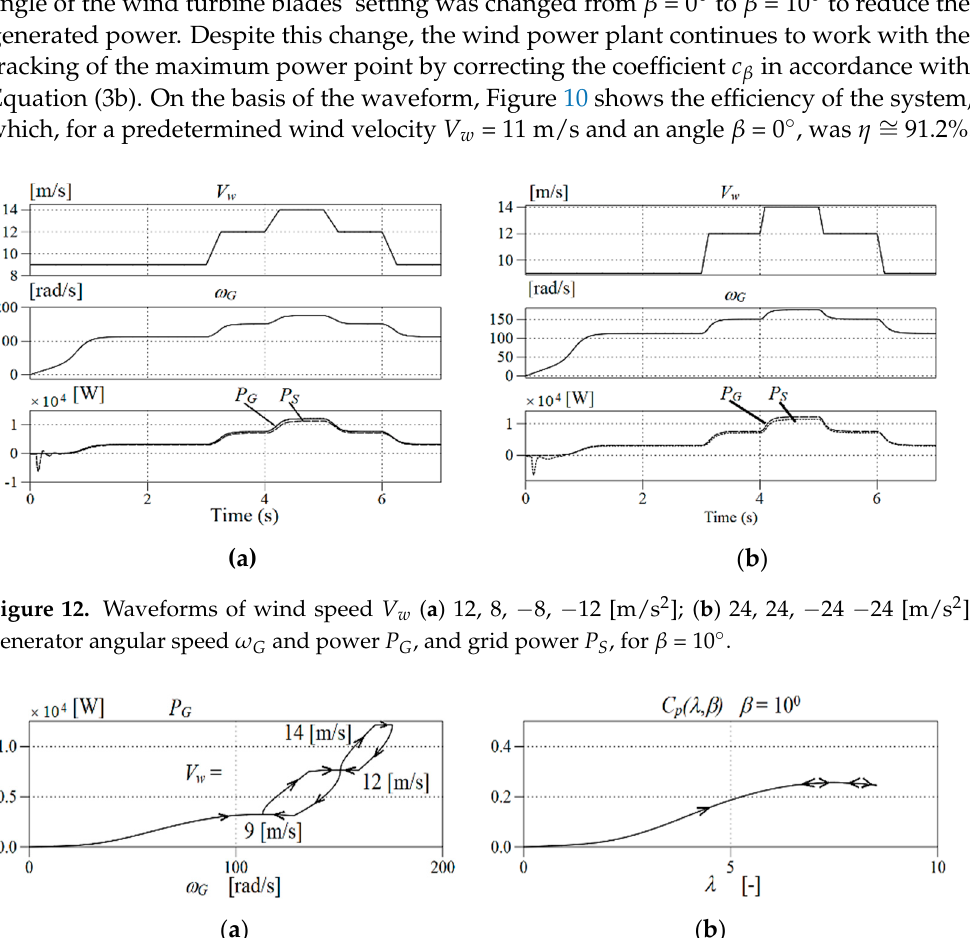
Figure 13. Waveforms of generator power P G ( a ) and turbine power coefficient C p ( λ , β ) ( b ) for changing wind speed V w and blade angle equal to β = 10° .